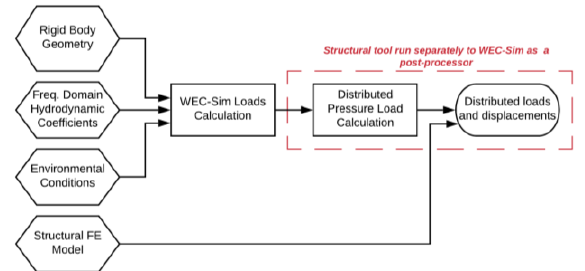
Bearing locations